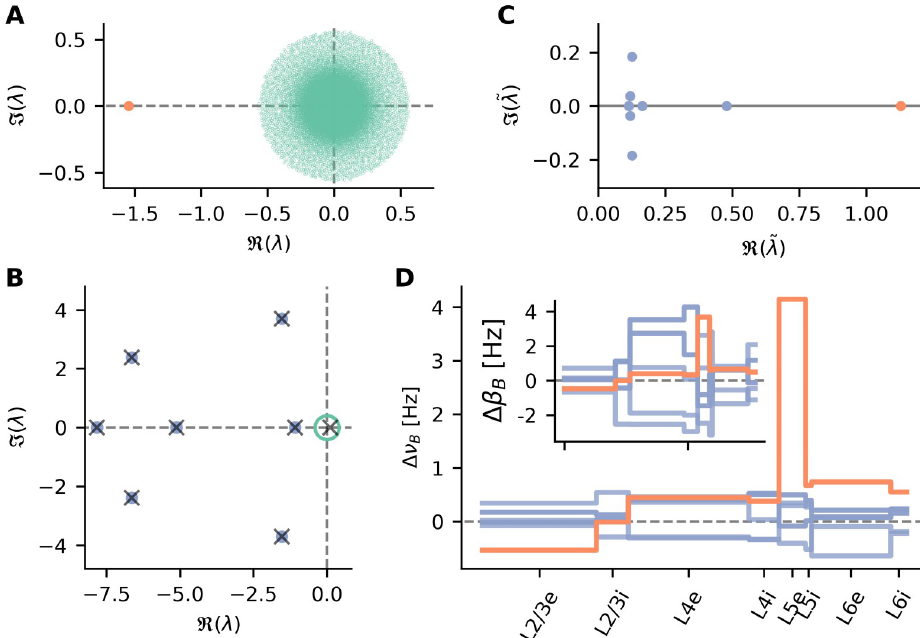
Fig 7. Eigenmode analysis of input-output relations. A Eigenvalue spectrum of the linearized model of Brunel [6]. The exceptional eigenvalue is shown in red, the bulk spectrum in green. B Eigenvalues of the close to 80000-dimensional linear system. Blue and green dots indicate the exceptional and bulk eigenvalues of W , respectively. Crosses mark eigenvalues of Q . C Eigenvalues of the matrix ð 1 (cid:0) Q Þ (cid:0) 1 . D The eight output modes of the Q system. Shown are the change in output rate for each single neuron, due to each mode. Inset: Input perturbation decomposed into the eight modes, which are also the right eigenvectors of Q